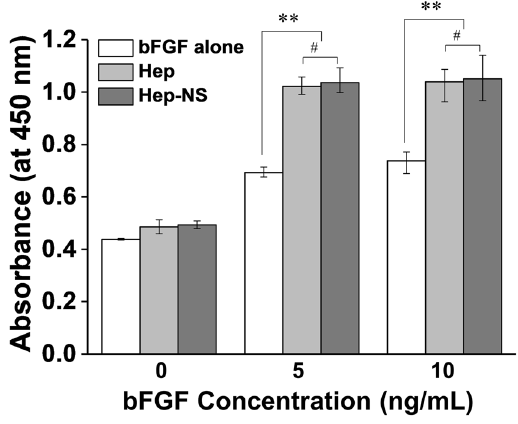
Figure 6. Bioactivity assay of bFGF treated with native heparin or Hep(24)-NS in Balb/c3T3 fibroblast cells (heparin concentration: 1 μ g/mL). (n = 3, # p > 0.05, * p < 0.05, and ** p <